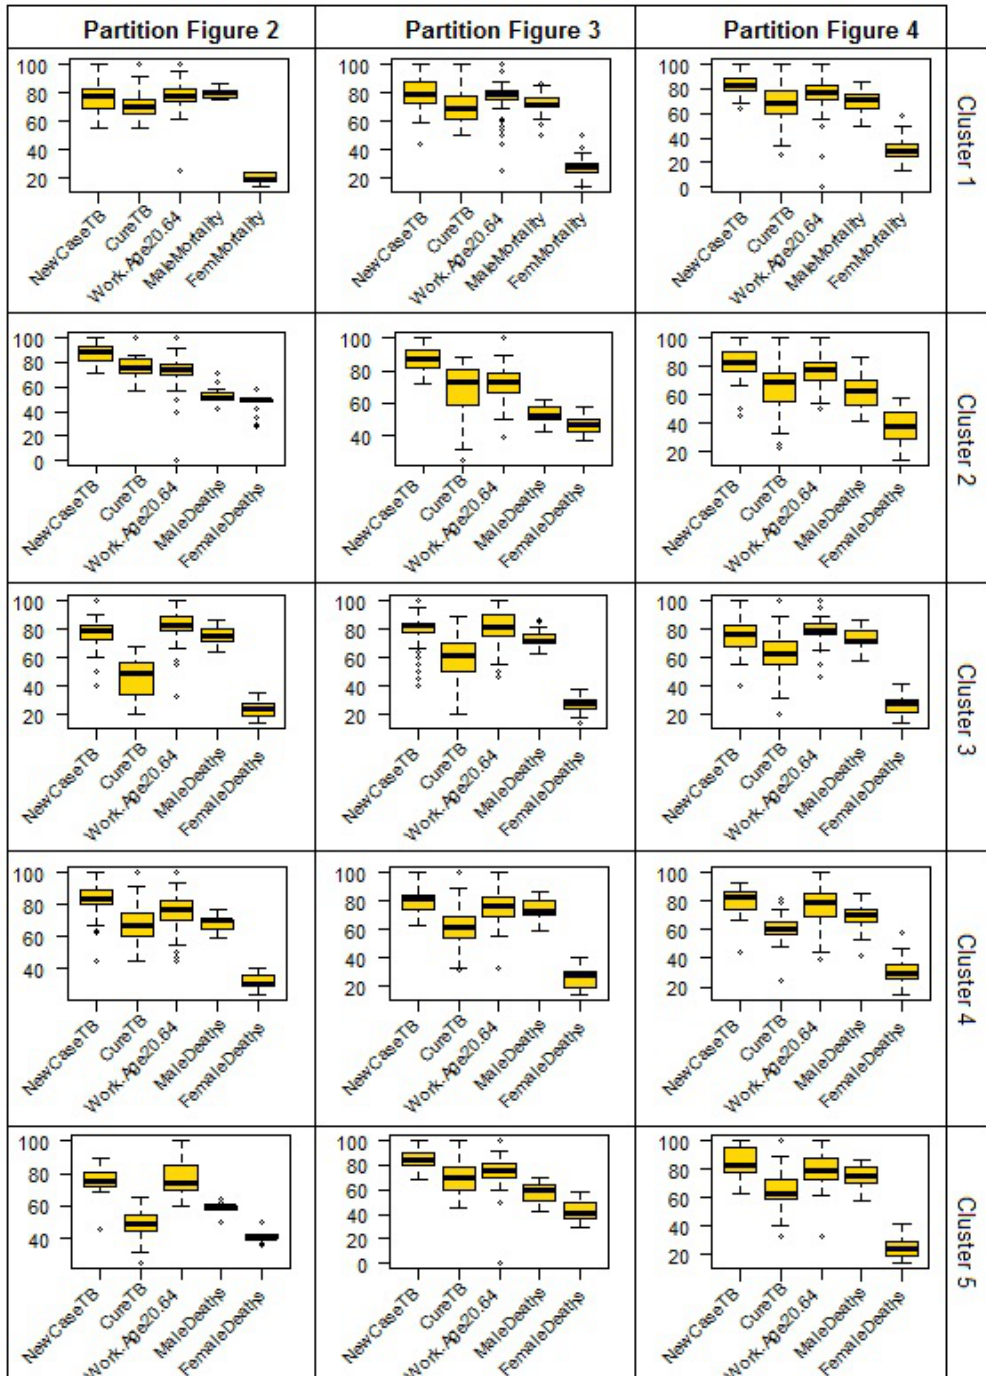
Figure A1. Comparison of clusters in the partition of Figures 2–4 in terms of